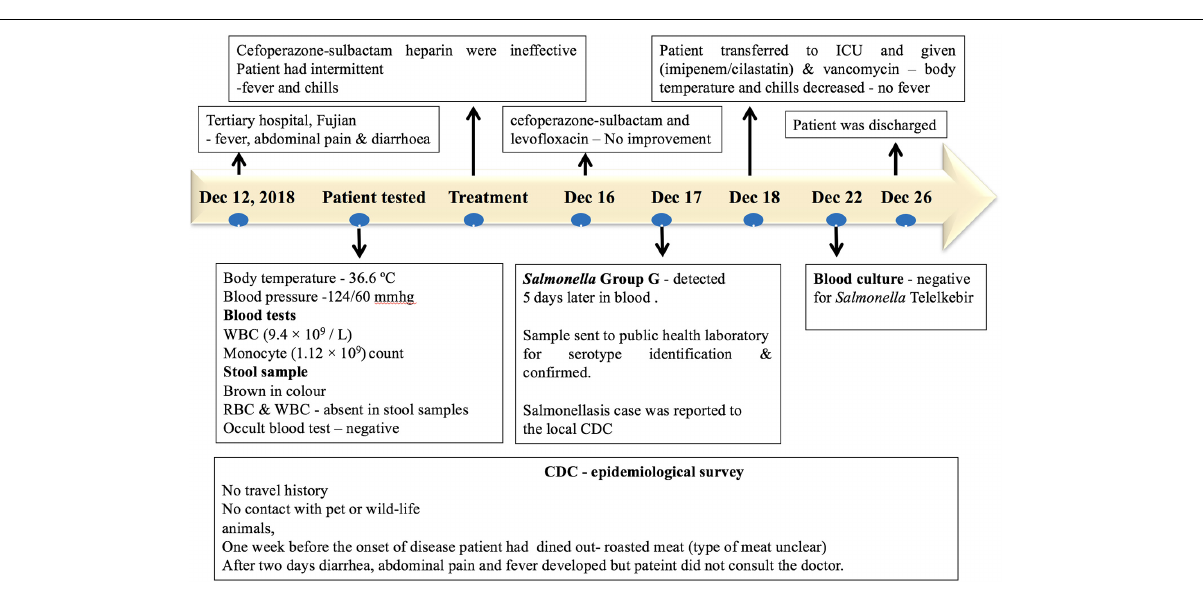
FIGURE 2 | Timeline of the salmonellosis diagnosis, treatment, and investigation since December 12,